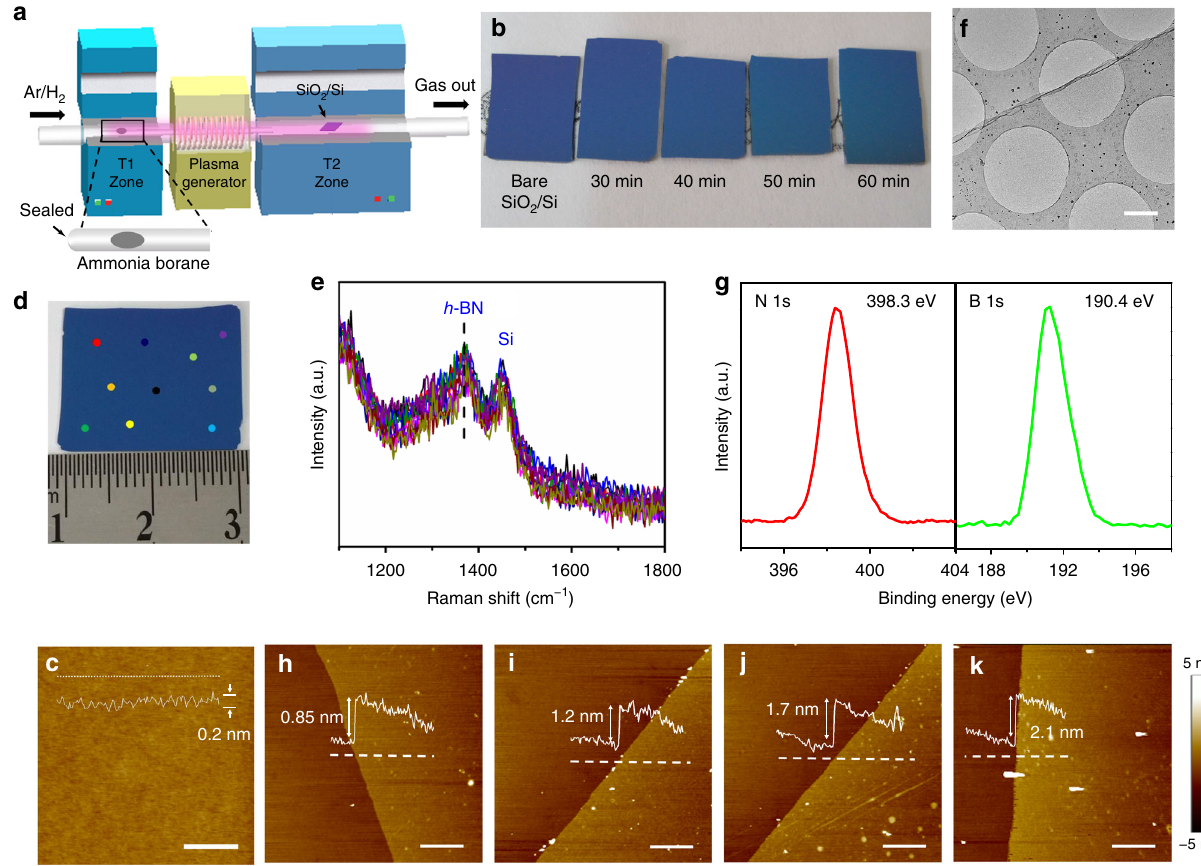
Fig. 1 Growth of two-dimensional hexagonal-boron nitride (2D-BN) by near-equilibrium plasma-enhanced chemical vapor deposition (PECVD). a Schematic illustration of the PECVD system. b Optical image of bare SiO 2 /Si, 2D-BN grown on SiO 2 /Si after 30, 40, 50, and 60 min growth, respectively. c Atomic force microscope (AFM) and d optical image of 2D-BN grown on SiO 2 /Si after 30 min growth. e Raman spectra collected from the dots in d . f Transmission electron microscope (TEM) image of a 2D-BN transferred onto a TEM grid. g X-ray photoelectron spectroscopy N1 s and B1 s spectra of 2D-BN grown on SiO 2 /Si. h – k AFM images of 2D-BN transferred to other SiO 2 /Si. The growth time is 30, 40, 50, and 60 min, respectively. The scale bars are 500 nm in c , 1 μ m in f , and 2 μ m in h –